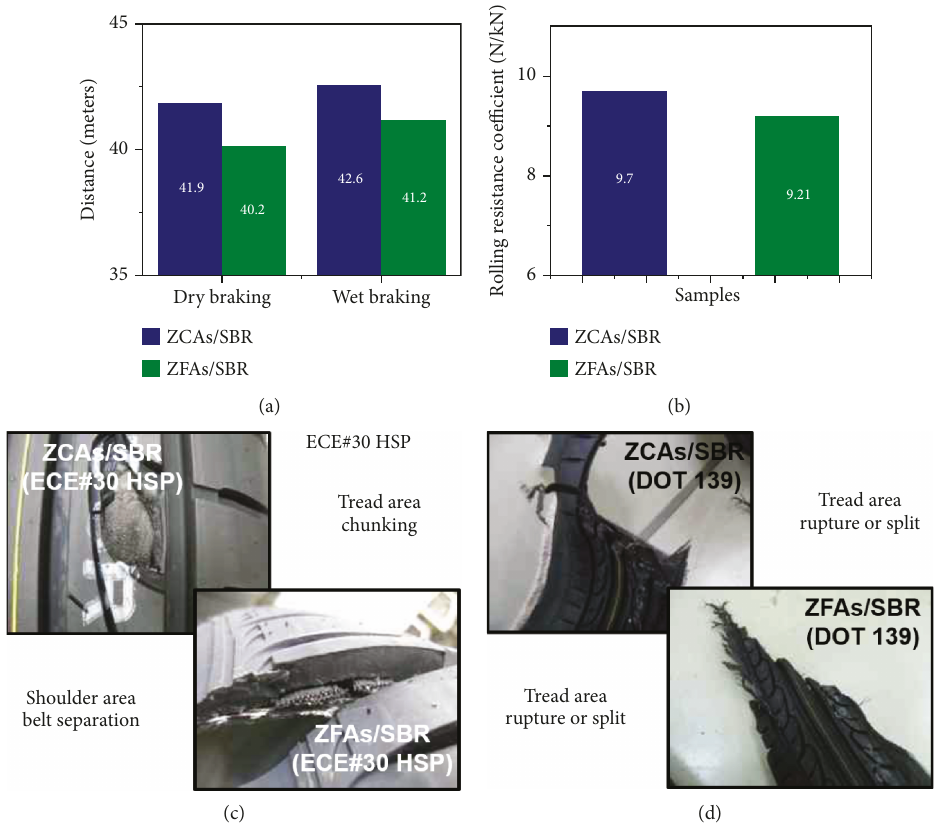
Figure 7: (a) Dry and wet braking properties, (b) rolling resistance coe ffi cients, (c) high-speed durability (ECE#30 HSP), and (d) high-speed durability (DOT 139) of pneumatic tires made with ZCA/SBR or ZFAs/SBR